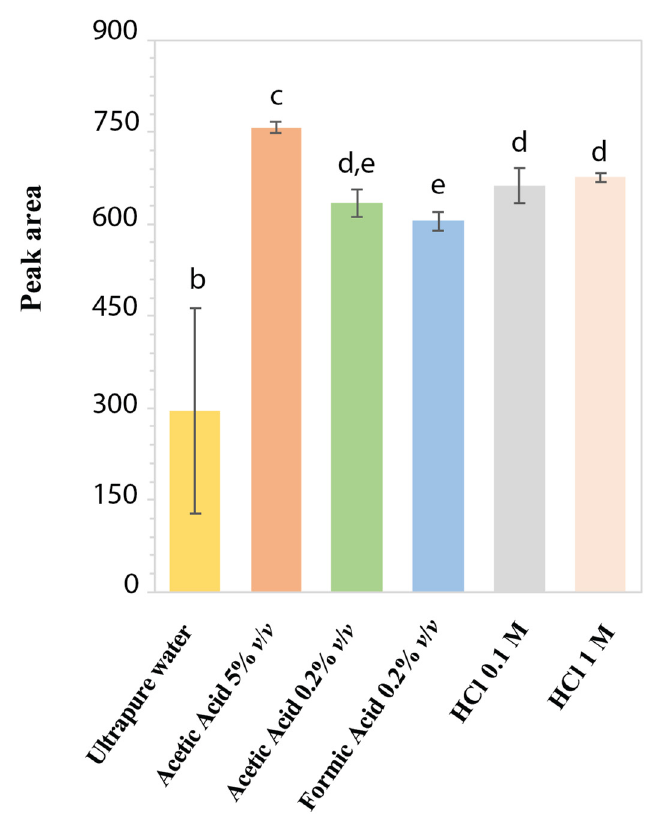
Figure 2. Stability histogram obtained by monitoring peak areas of LD standard solutions at 50 mg/L in different acidic media. Each bar represents the means ± standard deviation of the results obtained weekly for 3 consecutive months. Values marked by the same letter are not significantly different ( p < 0.05).